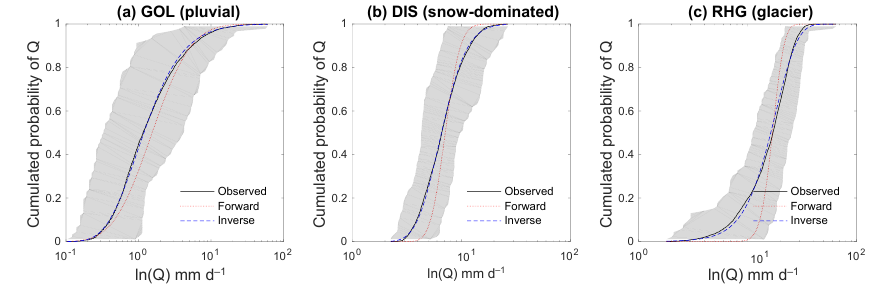
Figure 8. As Fig. 7 but for the nonlinear model.